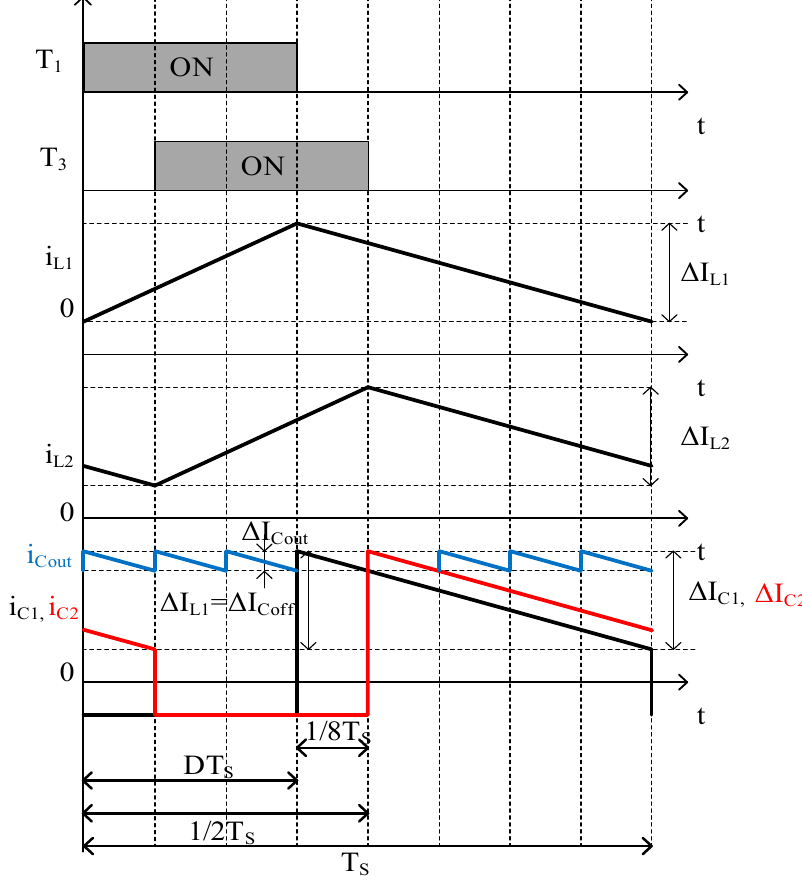
Figure A3. Output capacitor and inductor current of modular converter.